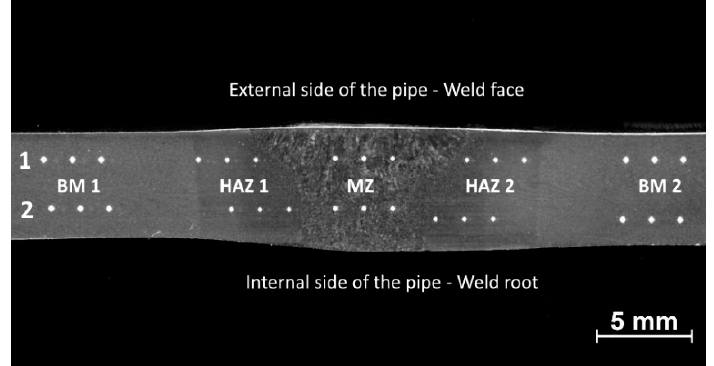
Figure 4. Example on how the microhardness indentations were produced across the cross-section.